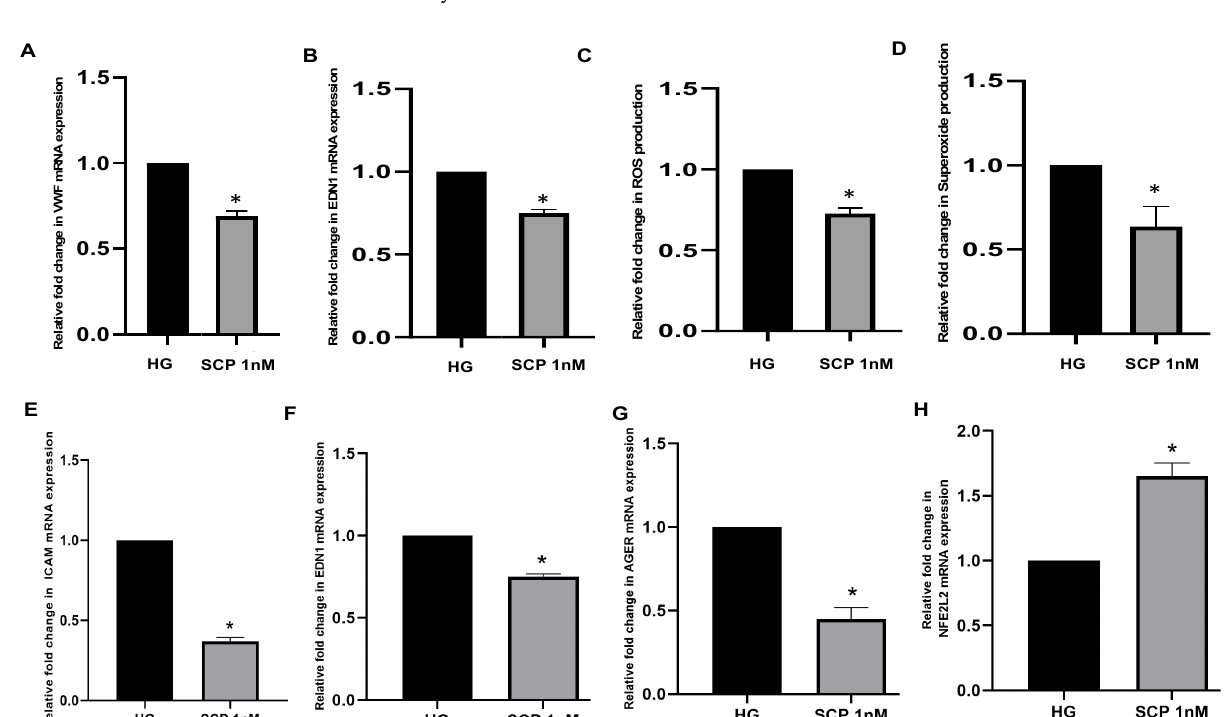
Figure 7. SC secreted C-peptide decreases endothelial dysfunction, activation and oxidative stress. Methods: PPECs ( A – D ) or HUVECs ( E – H ) were cultured for 4 h in high glucose (HG; 33 mmol/L D -glucose) or HG media containing NPSC ( A – D ) or MSC-1 ( E – H ) media with 1 nM of C-peptide (SCP). Real time PCR for VWF ( A ), EDN1 ( B , F ), ICAM ( E ), AGER ( G ) and NFE2L2 ( H ) was performed using mRNA isolated from treated PPECs or HUVECs. GAPDH was used as an endogenous control and the fold change for the gene of interest was calculated relative to the level in the reference sample (cells cultured in HG media). Oxidative stress was measured by quantifying levels of ROS ( C ) and superoxide ( D ). The fold change in the levels of ROS and superoxide was calculated relative to the level in the reference sample (cells cultured in HG media). Unpaired Student’s t -test (* p < 0.05) was used to determine significant differences as compared to HG.